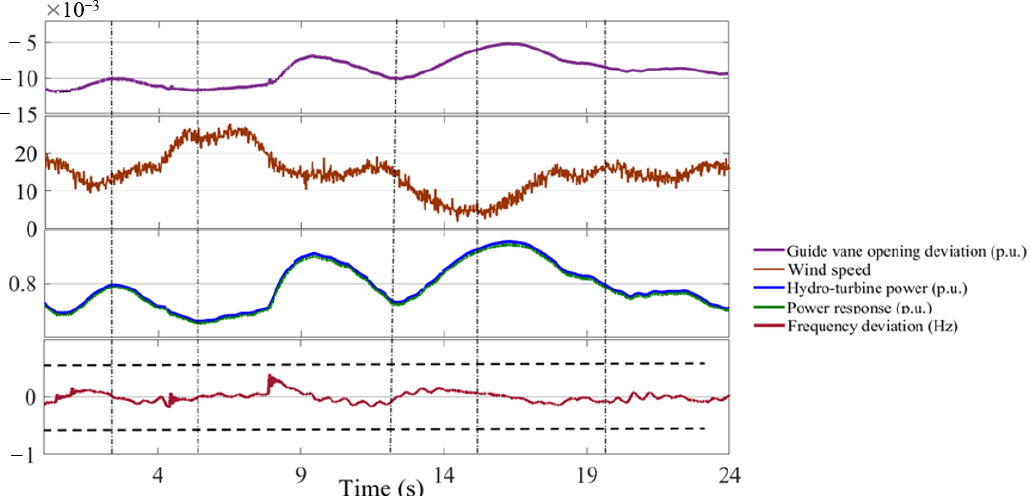
Figure 7. Complementary results of the wind-hydropower hybrid power system in the time scale of seconds (24 s in total). The dotted lines for the frequency deviation denote the accepted values, i.e., ±0.2 Hz. The power response is equal to the difference between the load demand and the actual output of wind power. The “p.u.” is the short for the unit of guide vane opening, hydro-turbine power and power response, the “Hz” is the short for the unit of frequency deviation, and the “s” is the short for the time unit.